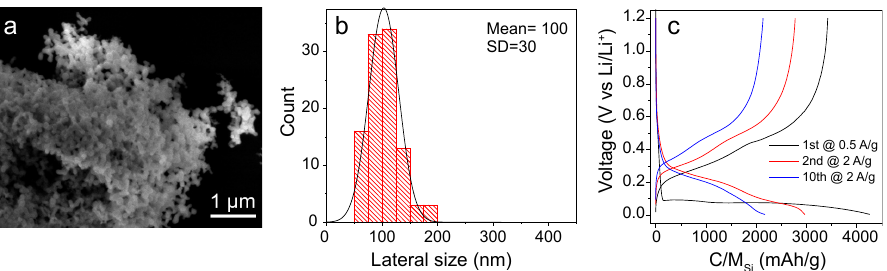
Figure 5. Representative SEM image of the SiNPs from US Research Nanomaterials ( a ). Size distribution of the SiNPs ( b ). GCD curves of the first 10 cycles of the SiNPs LIBs ( c ).